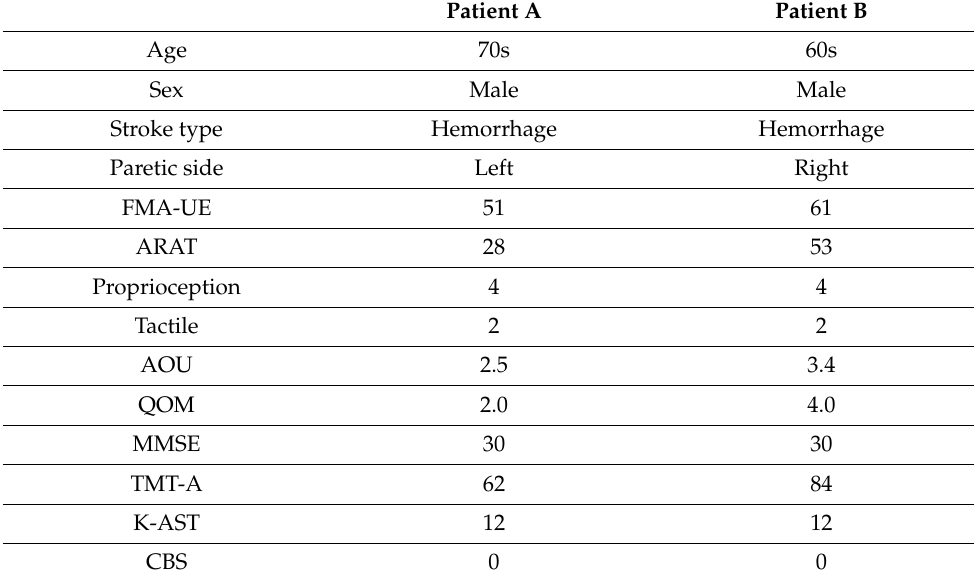
Table 1. Patients’ clinical characteristics.